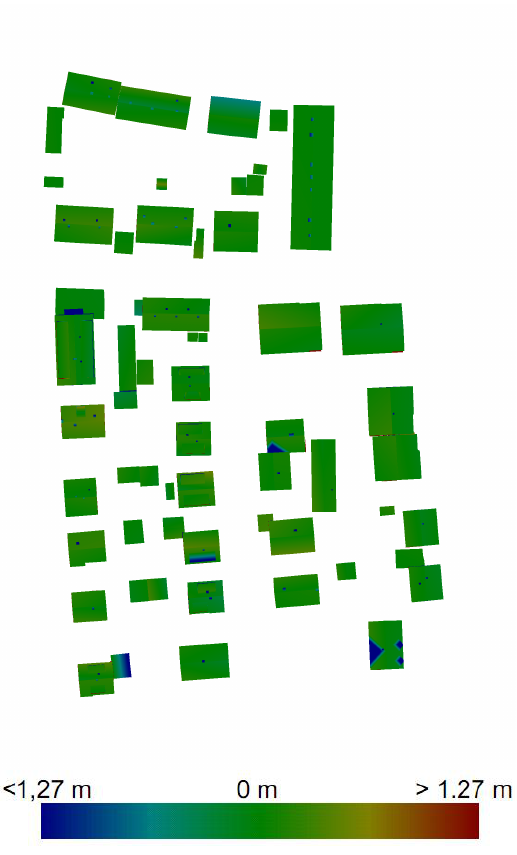
Figure 6. Evaluation of building detection on a per-pixel level